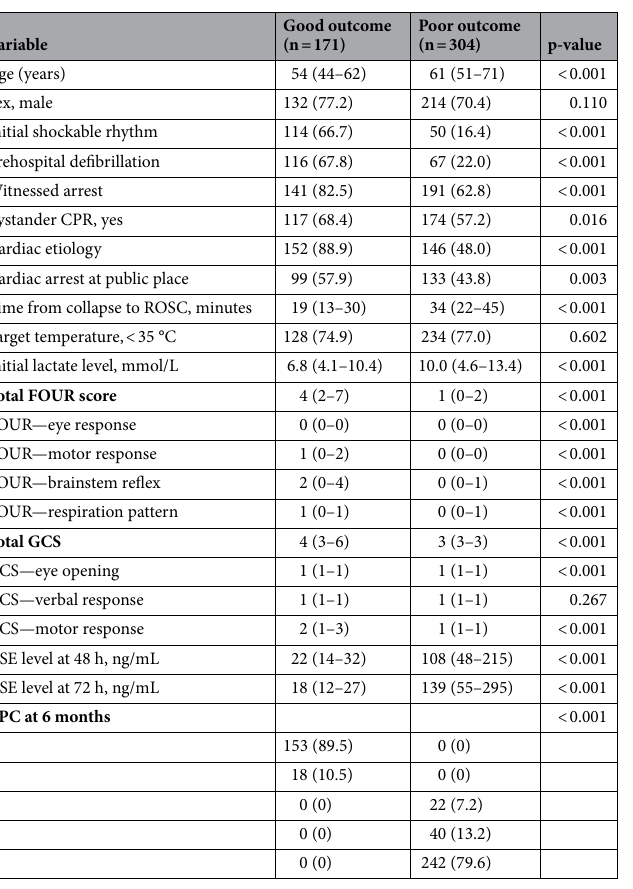
Table 1. Baseline characteristics and neurological outcomes 6 months after out-of-hospital cardiac arrest. Data are expressed as n (%) or medians (interquartile ranges). CPR: cardiopulmonary resuscitation; GCS: Glasgow Coma Scale; IQR, interquartile range; ROSC: return of spontaneous circulation; FOUR: Full Outline of UnResponsiveness; NSE: neuron-specific enolase; CPC: cerebral performance